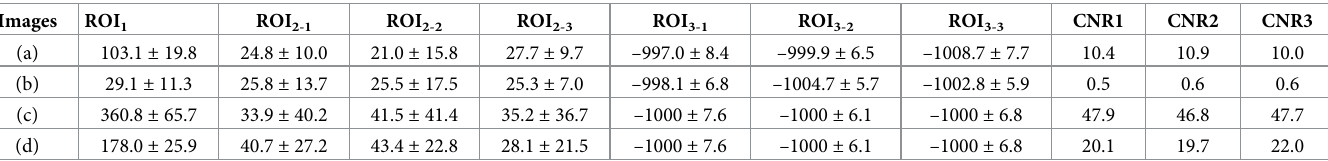
Table 1. Detailed values (HU) of mean ± SD and CNR at each ROI. These are used for quantitative evaluation of image quality of the multi-energy CT imaging shown in Fig 8. Images ROI 1 ROI 2-1 ROI 2-2 ROI 2-3 (a) 103.1 ± 19.8 (b) 29.1 ± 11.3 (c) 360.8 ± 65.7 (d) 178.0 ±